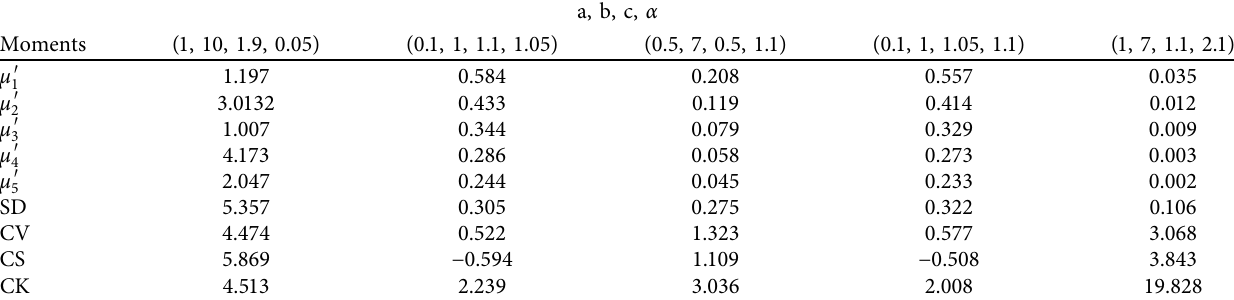
Table 2: Numerical values of the first five moments, SD, CV, CS, and CK for various parametric values.